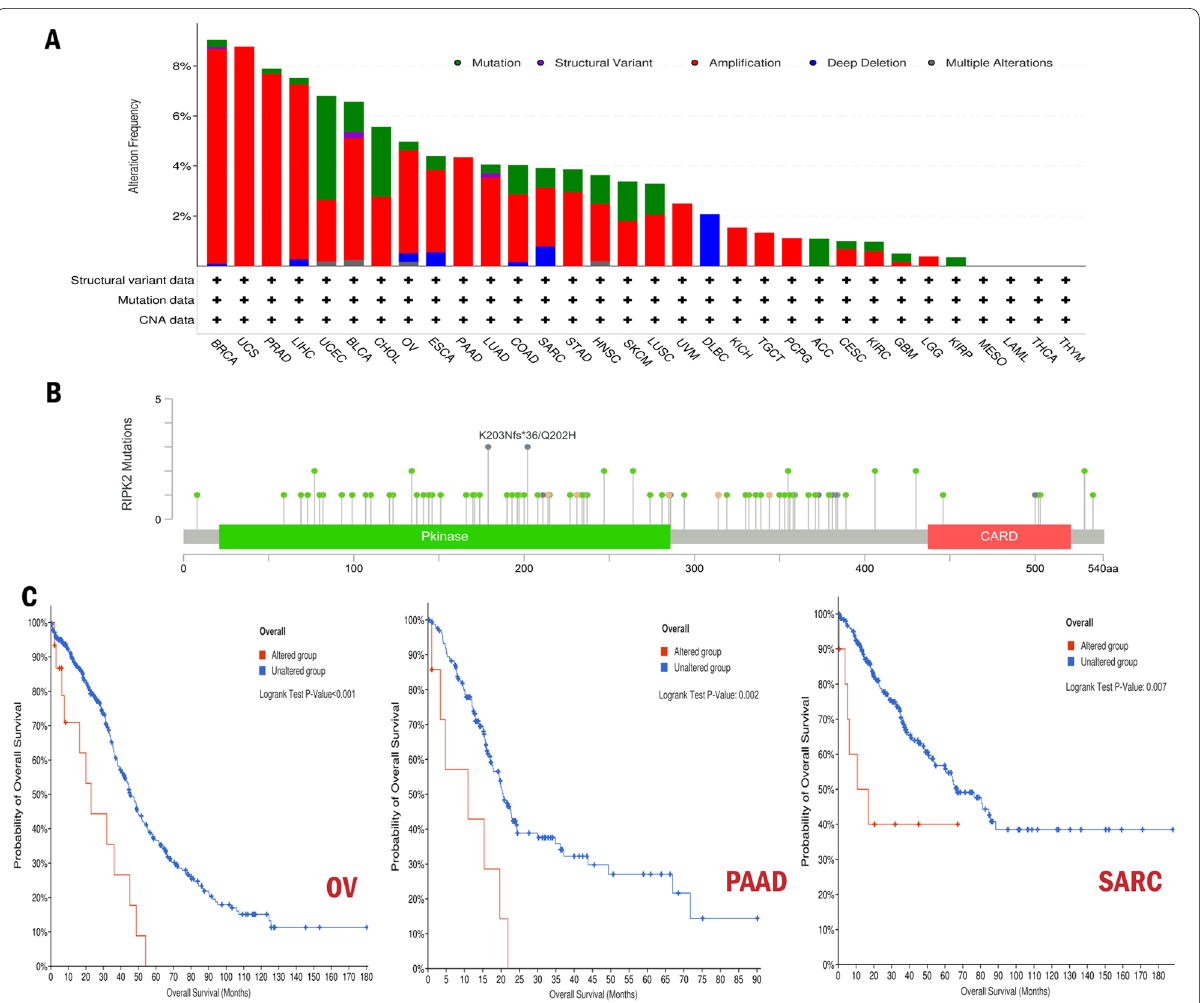
Fig. 3 Genetic alteration analysis of RIPK2 in different cancers. A Genetic alteration frequency and type of RIPK2. B RIPK2 mutation sites in TCGA samples. C Kaplan–Meier survival plots (OS) comparing altered and unaltered group in OV, SARC, and